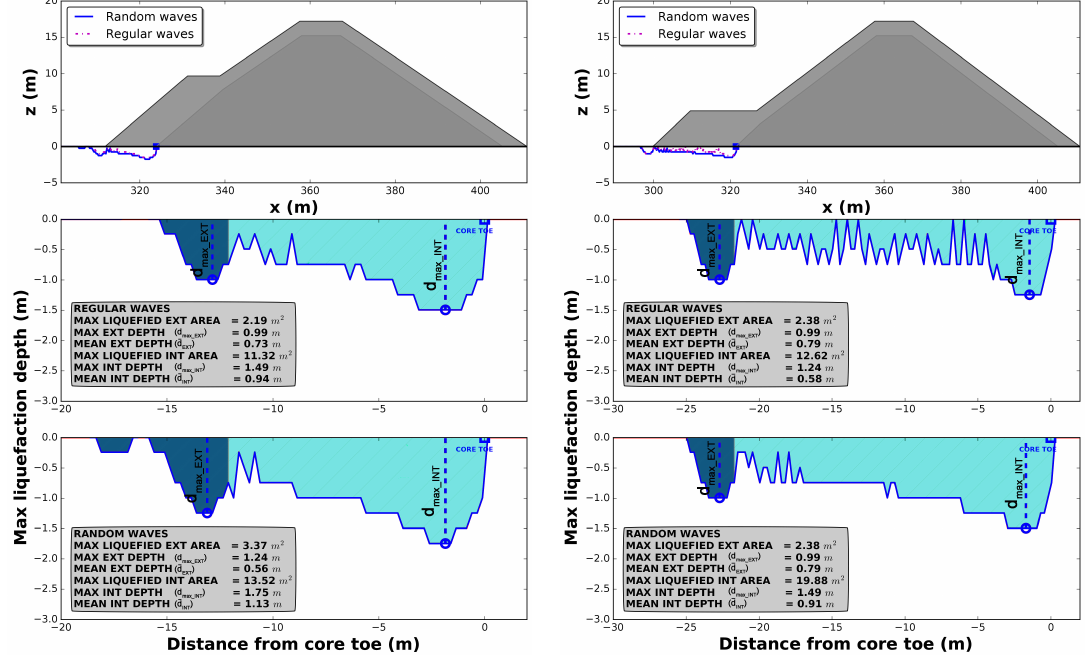
Figure 9. Wave-induced momentary liquefaction concerning breakwaters with submerged berms marked by h b / h t = 0.19 and L b / L w = 0.36 ( left panels), h b / h w = 0.59 and L b / L w = 0.36 ( right panels). Upper panels: maximum depth of momentary liquefaction around and below the structure. Middle panels: zoom of the maximum liquefied area induced by regular waves splits into two zones, in accordance with the location of the liquefaction occurrences. Blue subareas refer to maximum liquefaction depth ahead of the structure, down to the breakwater toe. Cyan subareas refer to maximum liquefaction depth below the structure. Lower panels: zoom of the momentary liquefaction maximum area induced by random